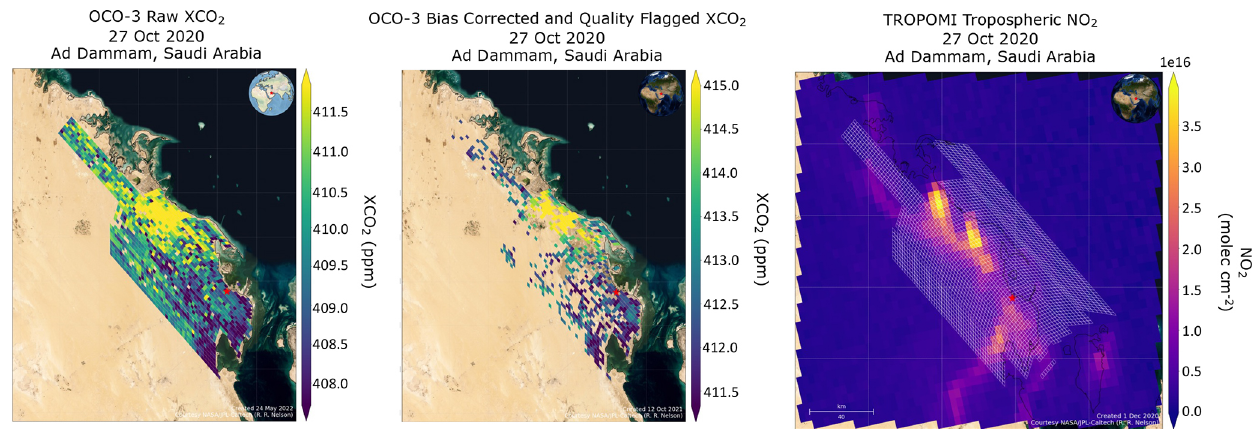
gradient due to a fossil fuel emission signal clustered 2